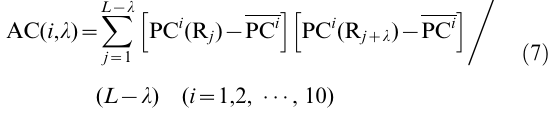
where l ~ (1, 2, (cid:2)(cid:2)(cid:2) , v L ) [15] and PC i represents the mean value of the i th horizontal line in Eq. 5 , as given by